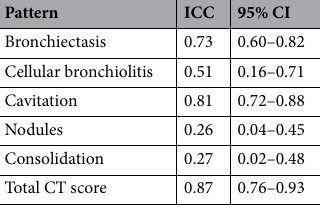
Table 2. ICC for each pattern of lung abnormality. ICC intraclass correlation, CI confidence interval, CT computed tomography.